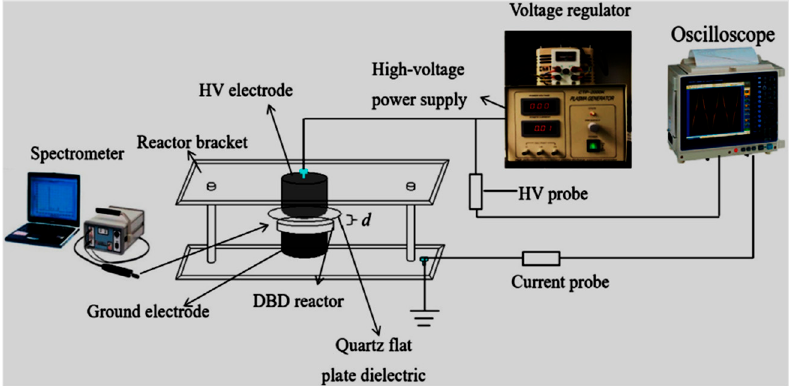
Figure 12. Dielectric barrier discharge (DBD) experimental system used for the decomposition of norfloxacin [167].